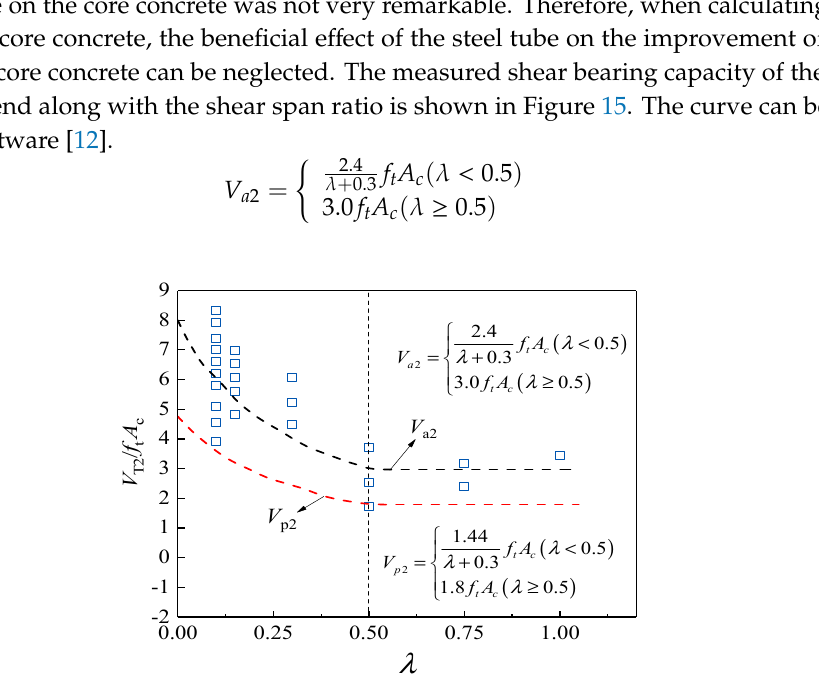
Figure 15. V a2 trend along with the shear span ratio.